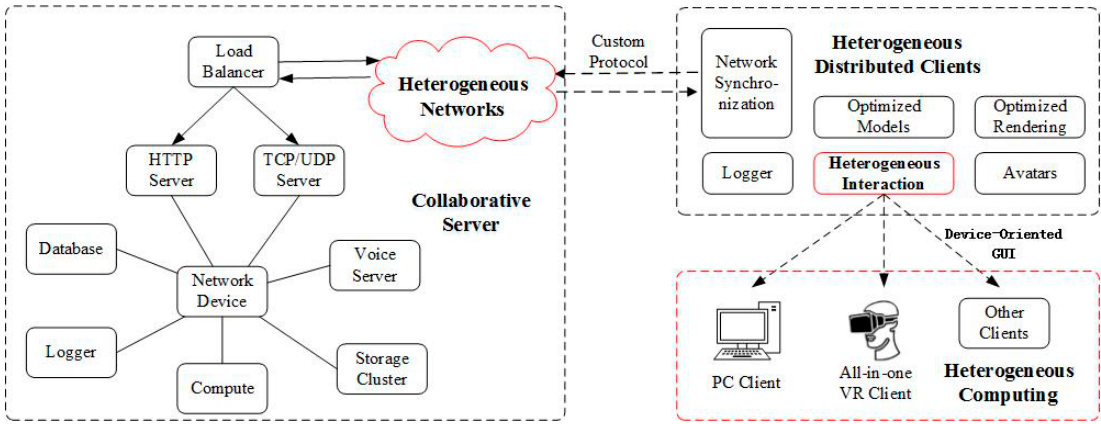
Figure 2. Architecture of HDVGE.